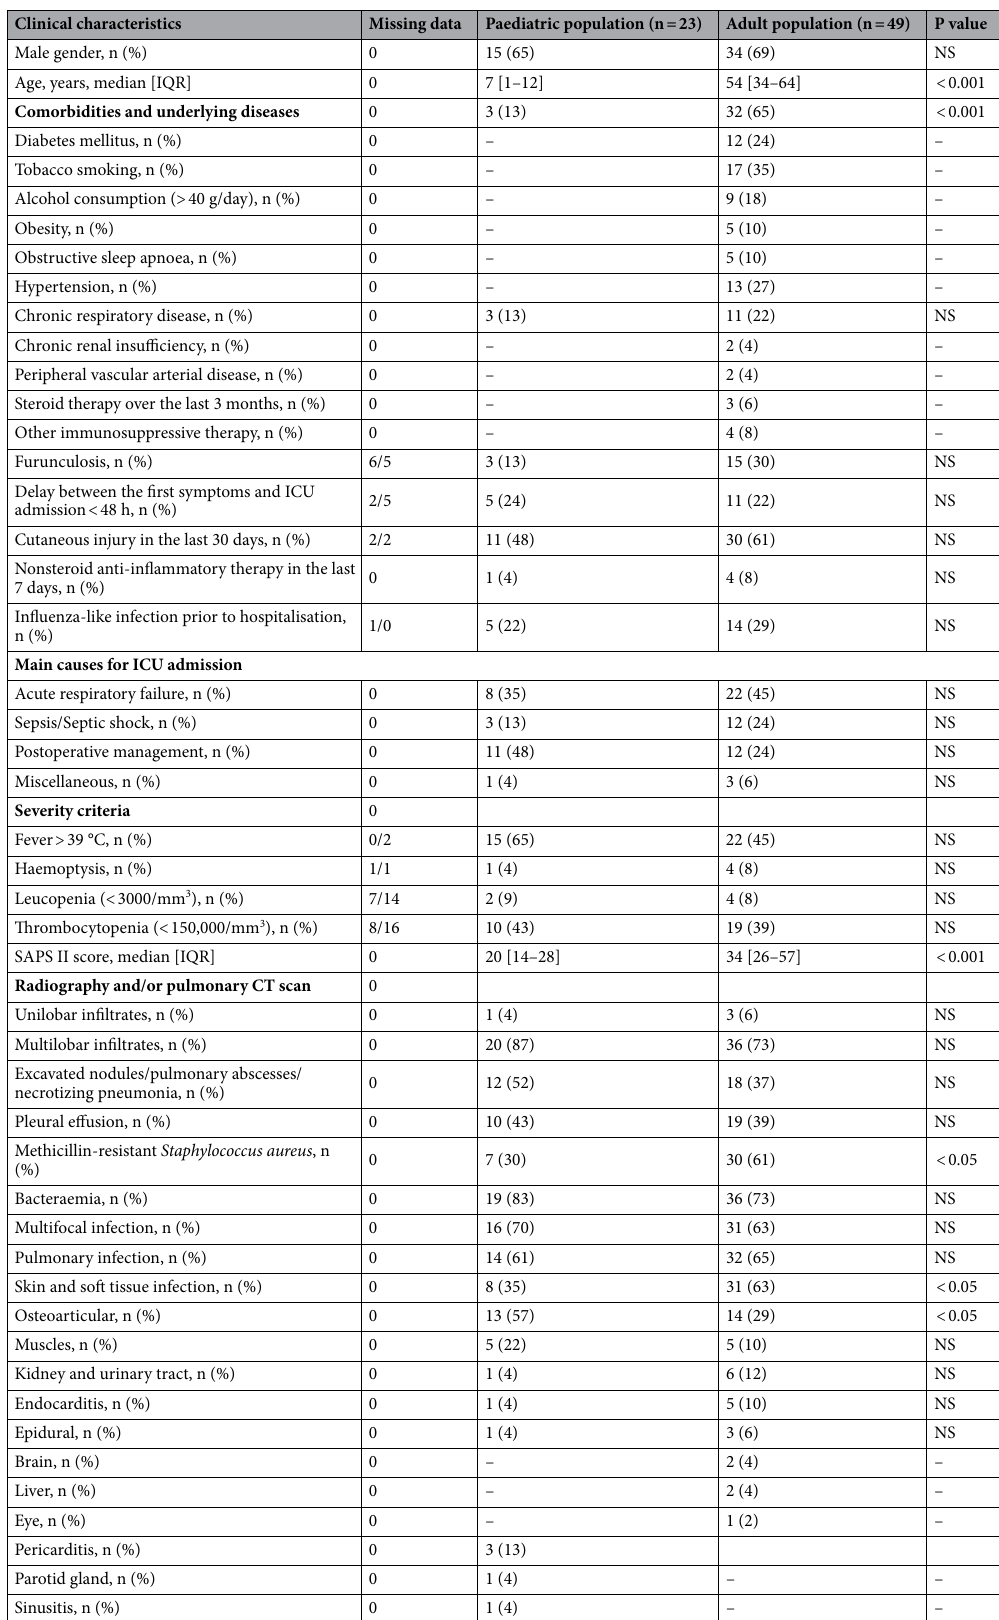
Table 1. Clinical characteristics at the time of ICU